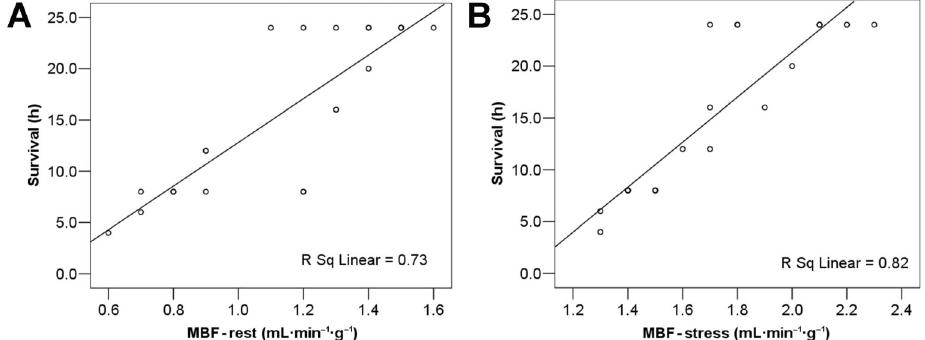
Figure 3. Correlation between myocardial blood fl ow (MBF) and survival time of dogs after return of spontaneous circulation at rest ( A ) and at stress ( B ).